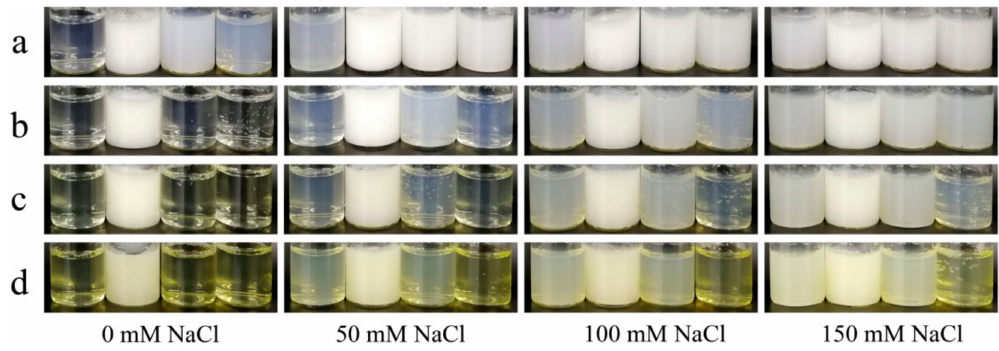
Figure 6. Photographs of EWP and IMO-EWP heat-induced particles prepared at different pHs and NaCl concentrations. EWP ( a ), 2.5% IMO-EWP ( b ), 10% IMO-EWP ( c ) and 50% IMO-EWP ( d ). Samples were adjusted to pH 3.0, 5.0, 7.0, 9.0 (vials from left to right in each image) and 0–150 mM NaCl was added as appropriate before heating.